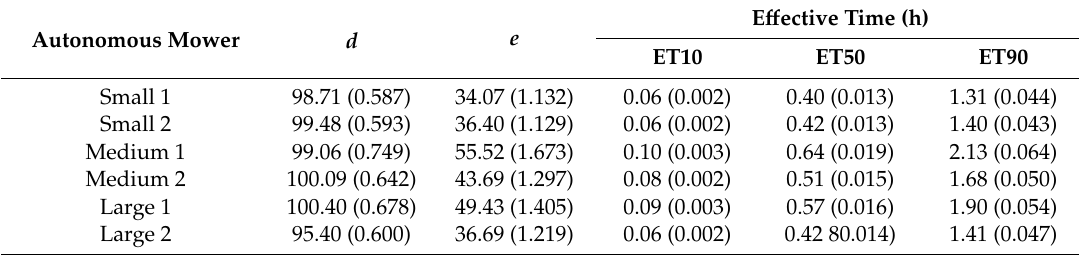
Table 4. Parameters of the non-linear asymptotic regressions (Equation (1)) and effective time of the autonomous mowers estimated from the two-stage meta-analysis dose–response model on Site A. Autonomous